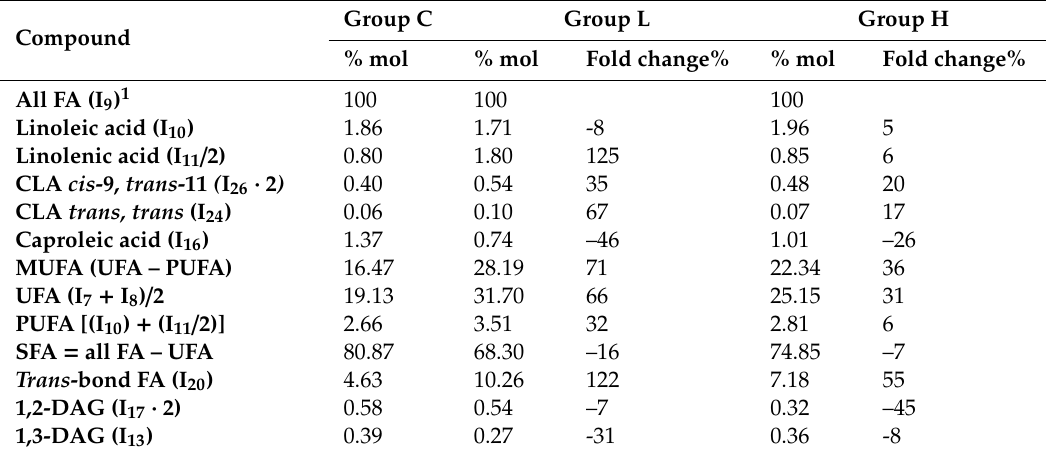
Table 2. FA (mol%) composition of milk from three groups of goats under di ff erent dietary regimens and fold changes (L or H – C / C)% due to supplements. C = control, L = linseed, H =